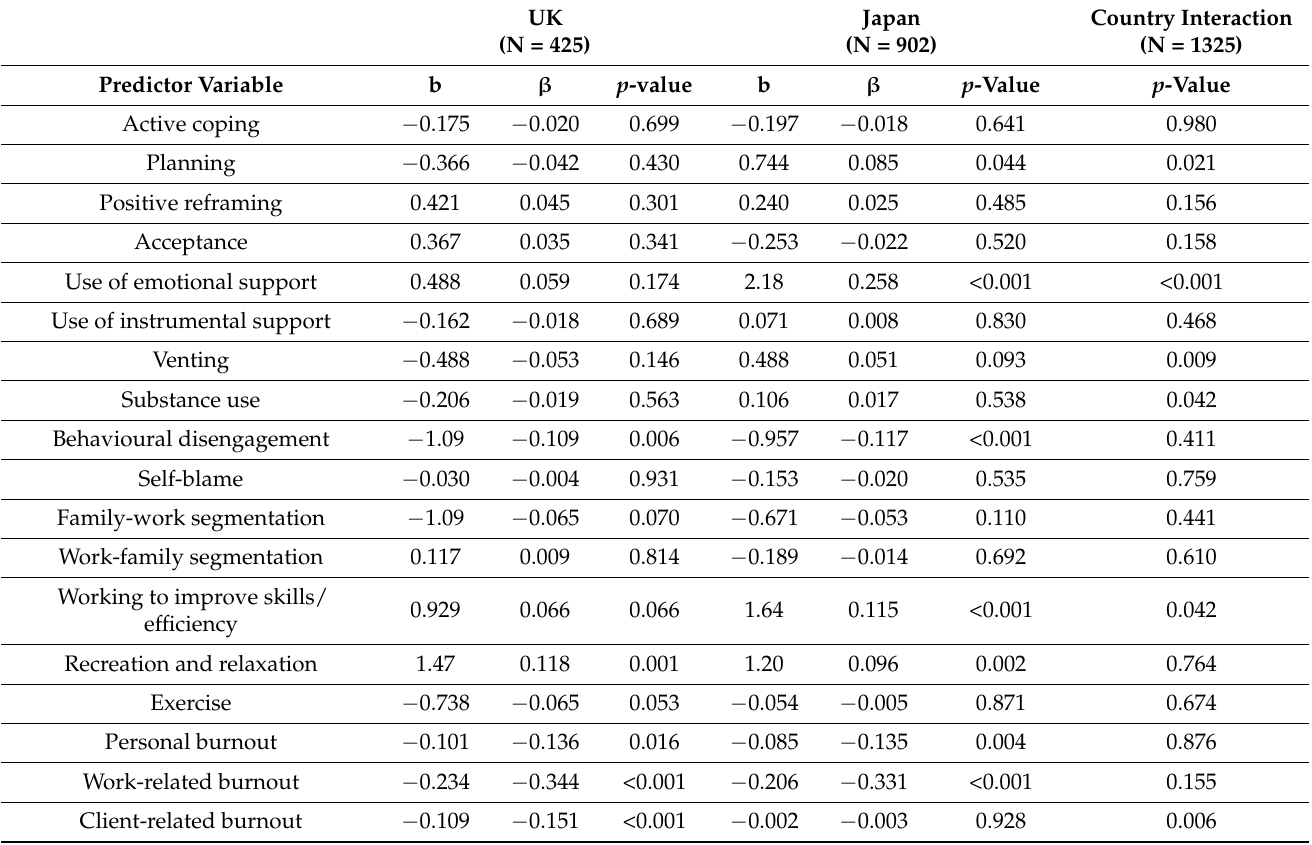
Table 4. Regression analysis examining coping strategies as predictors of